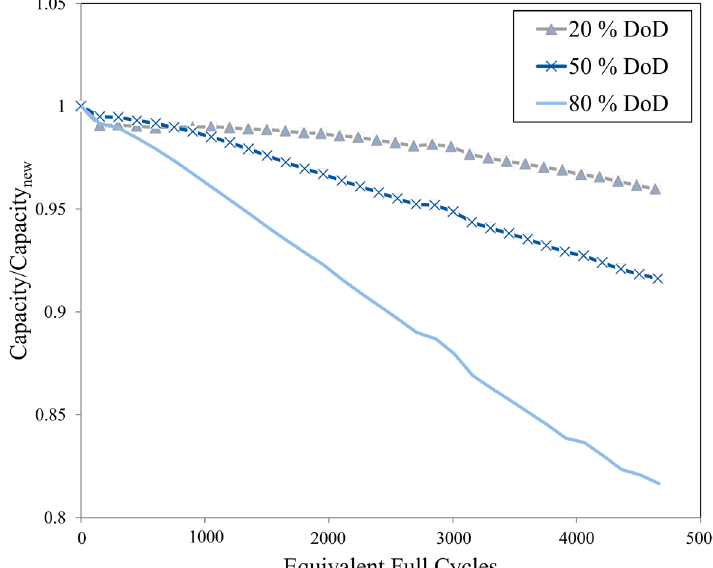
Figure 8. Reference aging analysis of a Kokam pouch